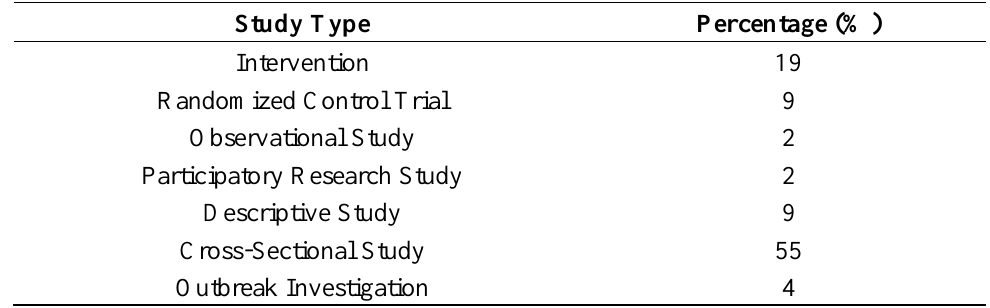
Table 2. Study types included from the forty-seven included studies (n = 47). Percentages rounded to the nearest whole number.